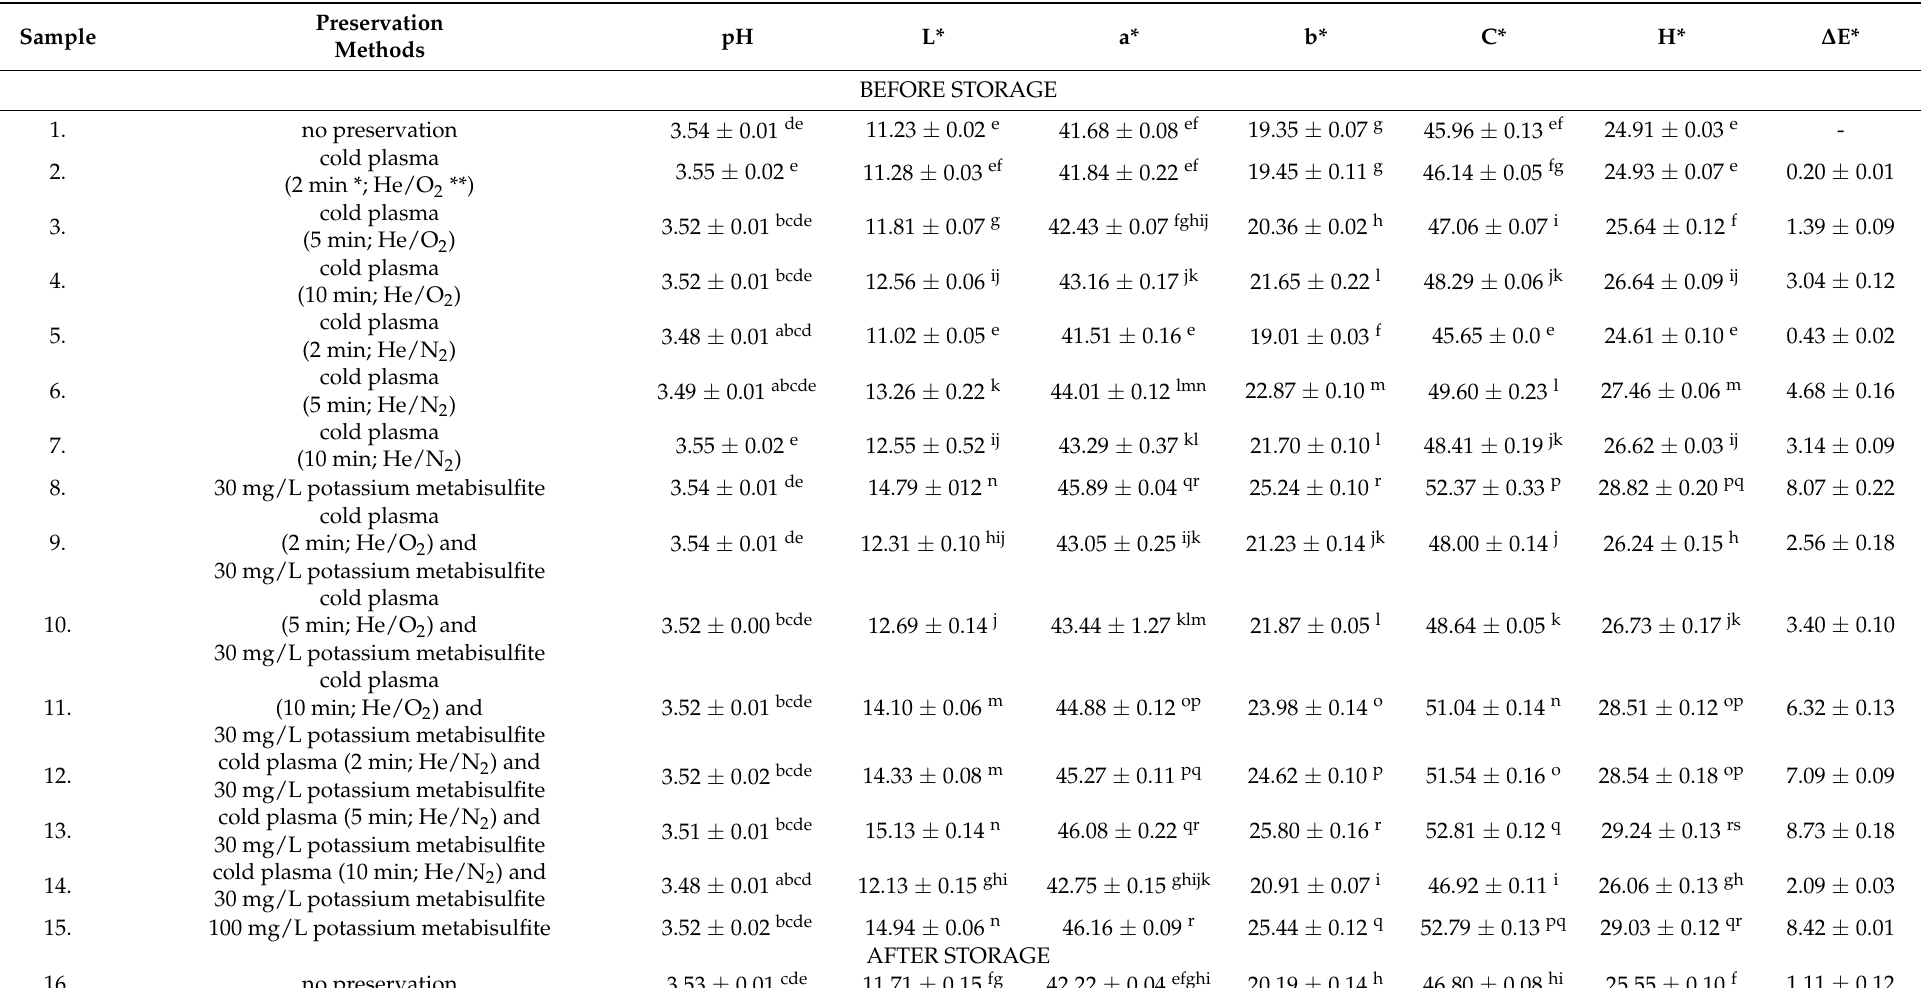
Table 1. Effect of different preservation processes and storage time on pH and color of red